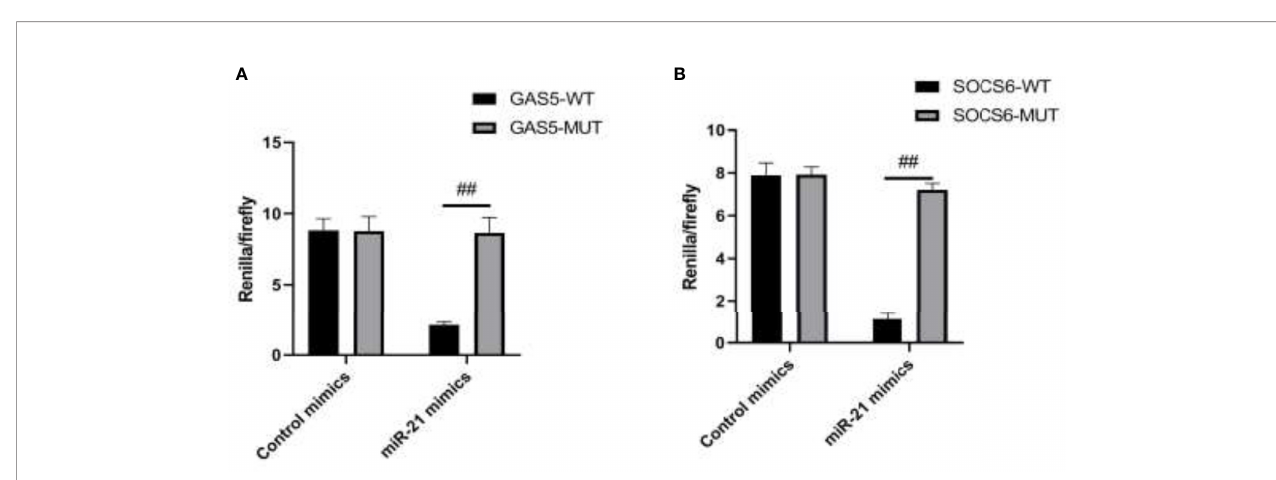
FIGURE 4 | The targeting relationship of GAS5/miR-21/SOCS6 is detected by a dual luciferase reporting system. (A) The targeting relationship of GAS5/miR-21 was detected by a double luciferase reporting system. (B) The targeting relationship of miR-21/SOCS6 was detected by a dual luciferase reporting system. Statistical signi fi cance was determined by the Student ’ s t -test ( ## p <